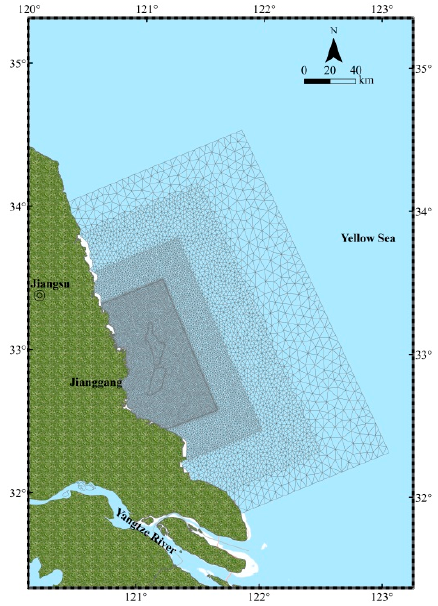
Figure 2. Grid generation of the study area.